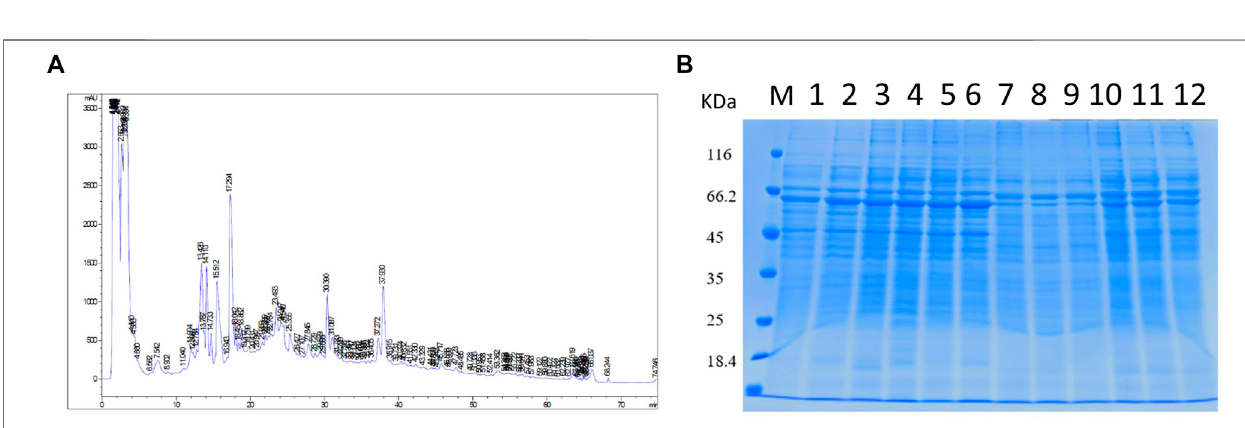
FIGURE2| Qualitycontrolandoverallprimaryresults. (A) ExtractthetotalproteininthesampleandtakeoutapartforproteinconcentrationdeterminationtoSDS- PAGE detection. The molecular weights from top to bottom are as follows: 116, 66.2, 45,35, 25, and 18.4 (kDa). (B) High-pH RP chromatography separation peak diagram. The protein istrypsinized and labeled, and then the same amount of each labeled sample is mixed for chromatographic separation.1 – 12: BCG in-1, BCG in-2, BCG in-3, M.tb in-1, M.tb in-2, M.tb in-3, BCG1, BCG2, BCG3, M.tb 1, M.tb 2, M.tb 3.